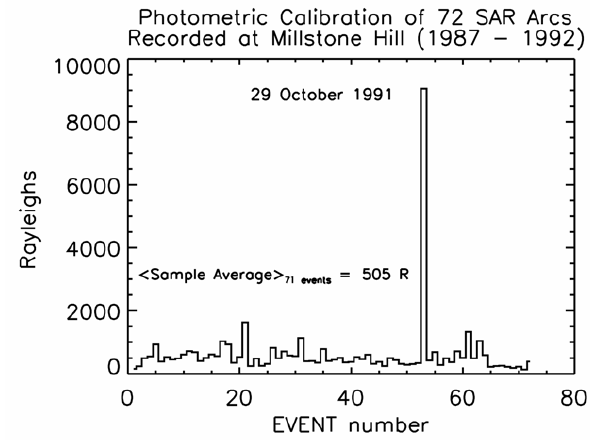
Fig. 1. Characterization of 72 SAR arc events by observed bright- ness in Rayleighs (R) above background. No atmospheric extinc- Figure 1. Characterization of 72 SAR arc events by observed tion corrections have been made. brightness in Rayleighs (R) above background. No atmospheric extinction corrections have been made.